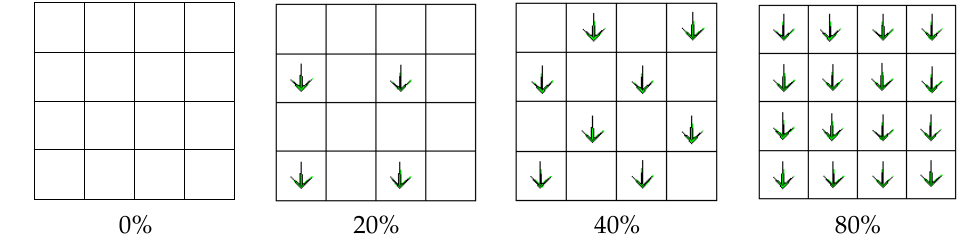
Figure 3. Sketch map of vegetation arrangement.